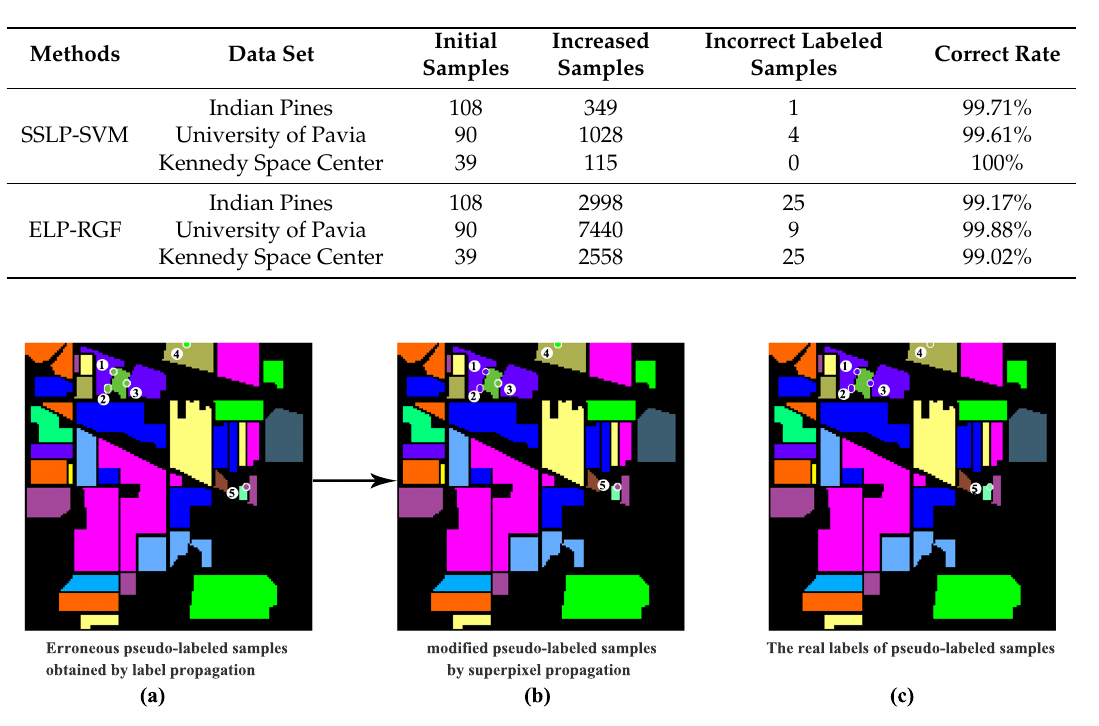
Table 5. Correct rate of samples generated by the two semi-supervised methods of three datasets.